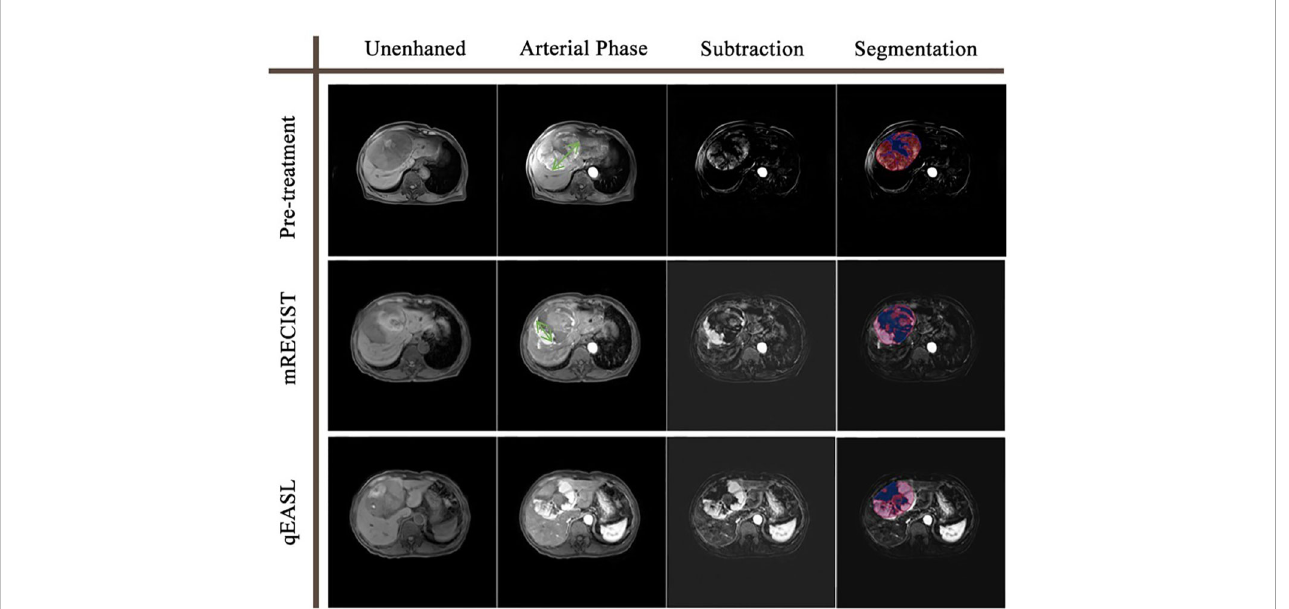
FIGURE 2 Tumor response evaluation based on the contrast-enhanced MR of a 78-year-old man with one HCC tumor. The green double-sided arrows represent the measurement of the diameter of the largest viable tumor on arterial phase images. The color maps represent the segmentation using the qEASL method, where blue maps illustrate inactive areas and red maps indicate viable tumors. The viable tumor volume was 494.2 cm 3 at baseline and 292.5 cm 3 after the initial TACE. The 40.8% viable tumor volume reduction suggested that this patient was a non-responder to TACE. In comparison, the diameter of the viable tumor was 11.5 cm at baseline and 6.7 cm after the initial TACE. The 41.7% diameter reduction suggested that this patient was a responder to TACE. The disagreement of the two evaluation methods may result from the irregular shape of the necrosis